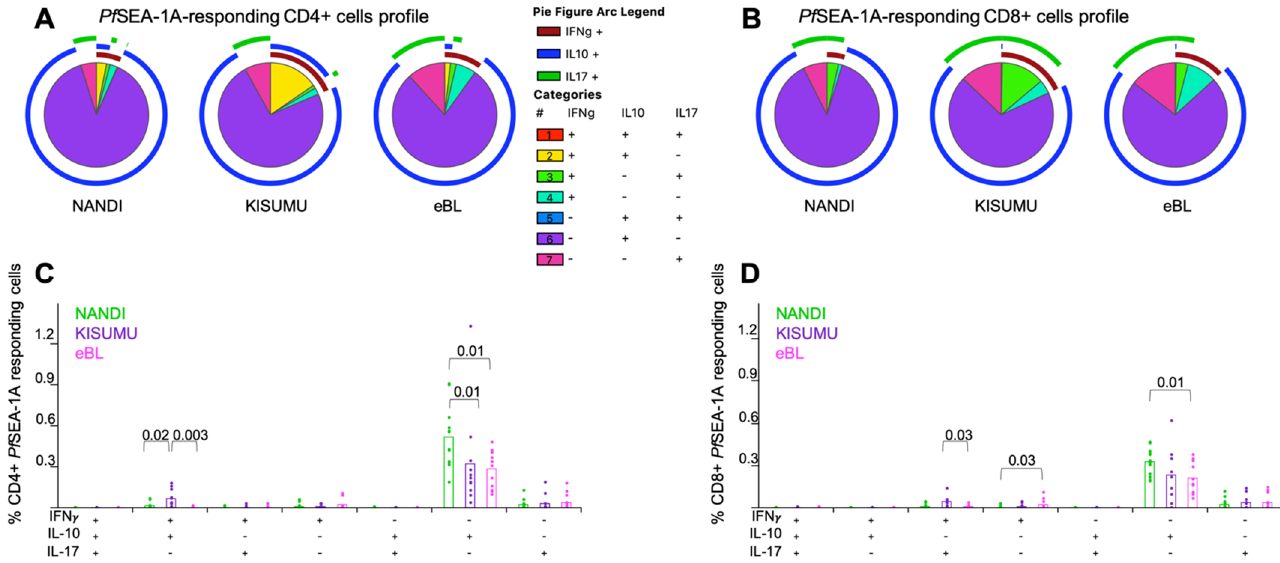
Figure 4. Mono- and poly-functional T cell profiles to Pf SEA-1A. Functionality of cells after Pf SEA-1A stimulation were compared across study groups. Each pie slice represents the type of cytokine expression from ( A ) CD4 + and ( B ) CD8 + T cells; arcs show co-cytokine expression. The frequencies of each type of cytokine-expressing T cells were compared across study groups (Nandi in green, Kisumu in purple and eBL in pink) after Pf SEA-1A stimulation for ( C ) CD4 + and ( D ) CD8 + T cells. Bar plots show the mean for each group of children and each dot represents an individual. Wilcoxon Rank Sum Test p values < 0.05 are indicated.